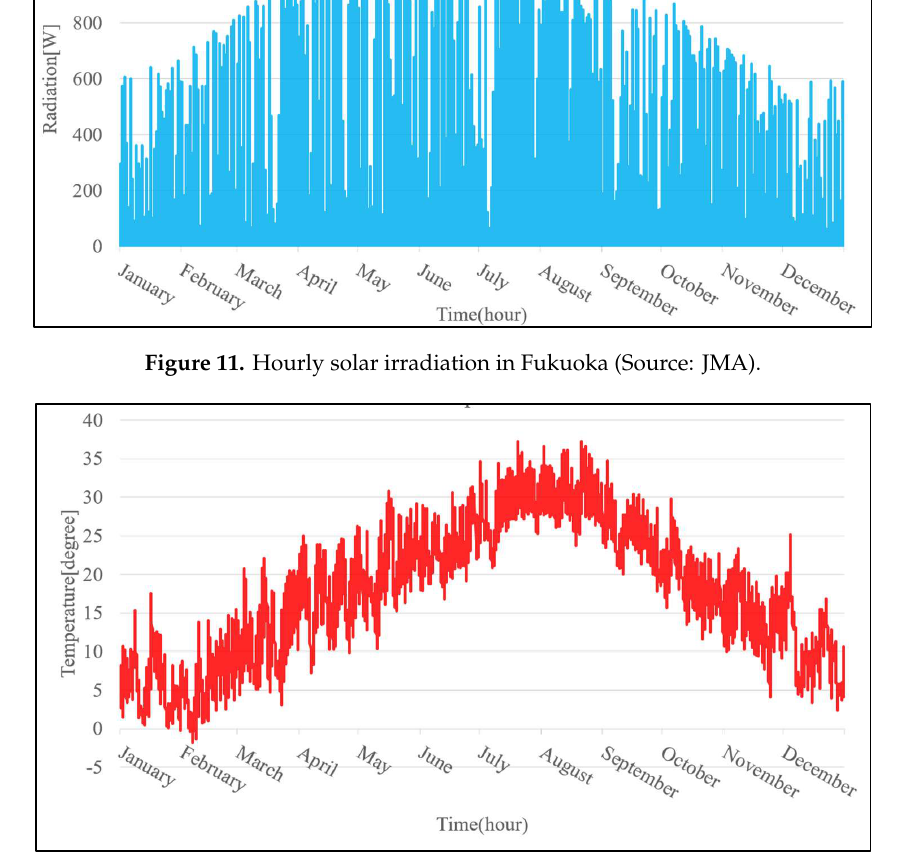
Figure 12. Hourly ambient temperature in Fukuoka (Source: JMA).